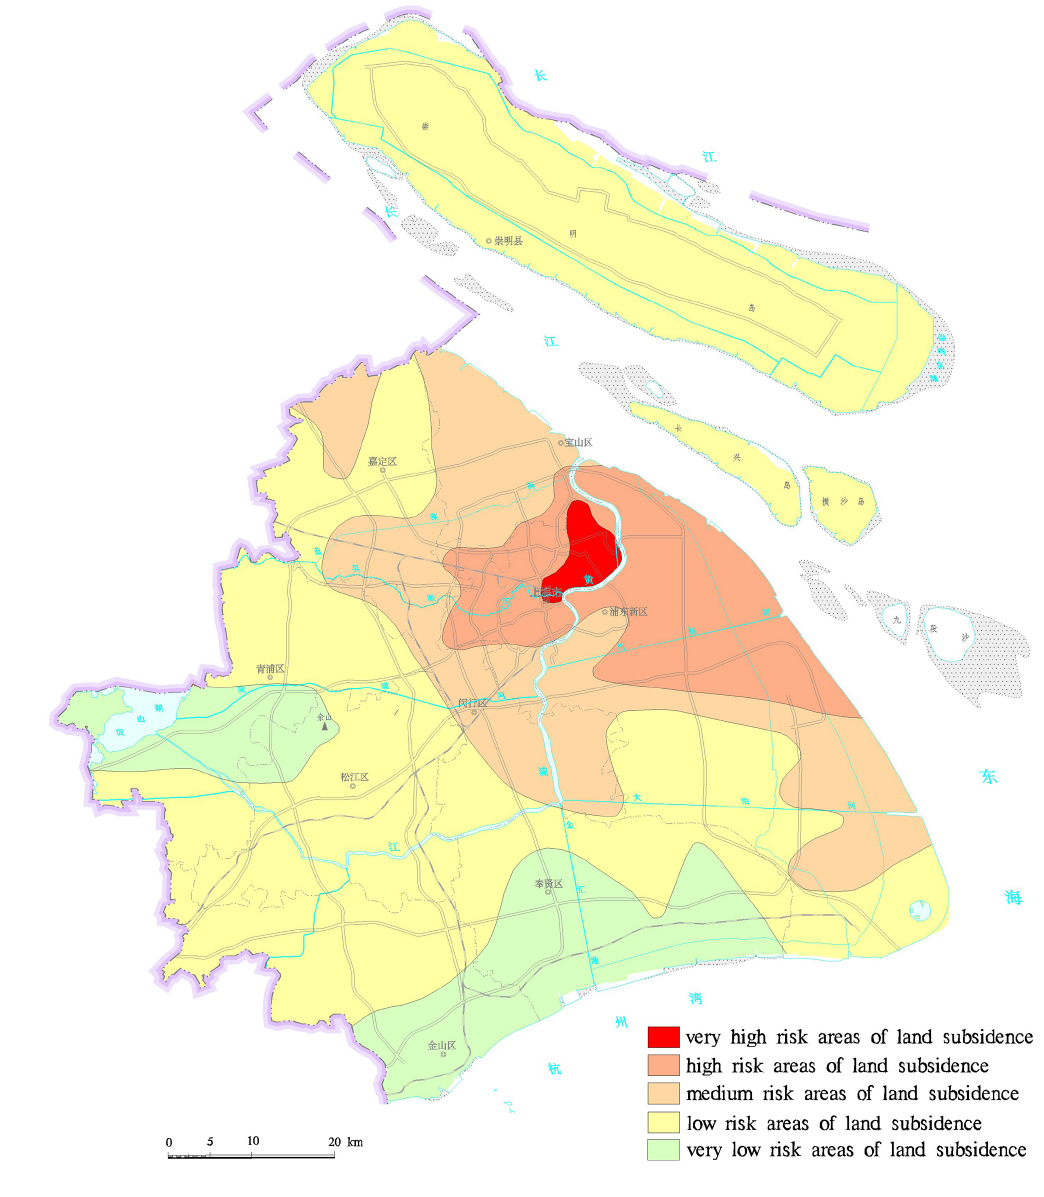
Figure 3. Risk evaluation of land subsidence in